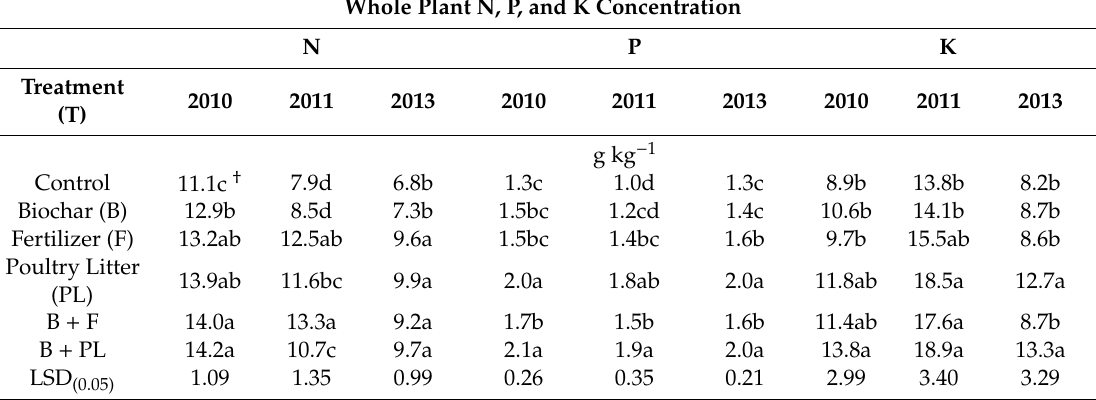
Table 3. Whole plants nutrients (N, P, and K) concentrations influenced by di ff erent treatments and growing season